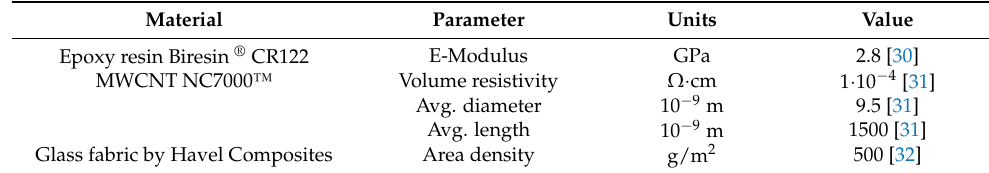
Table 1. Basic properties of used materials for composite preparation by manufacturers’ data.